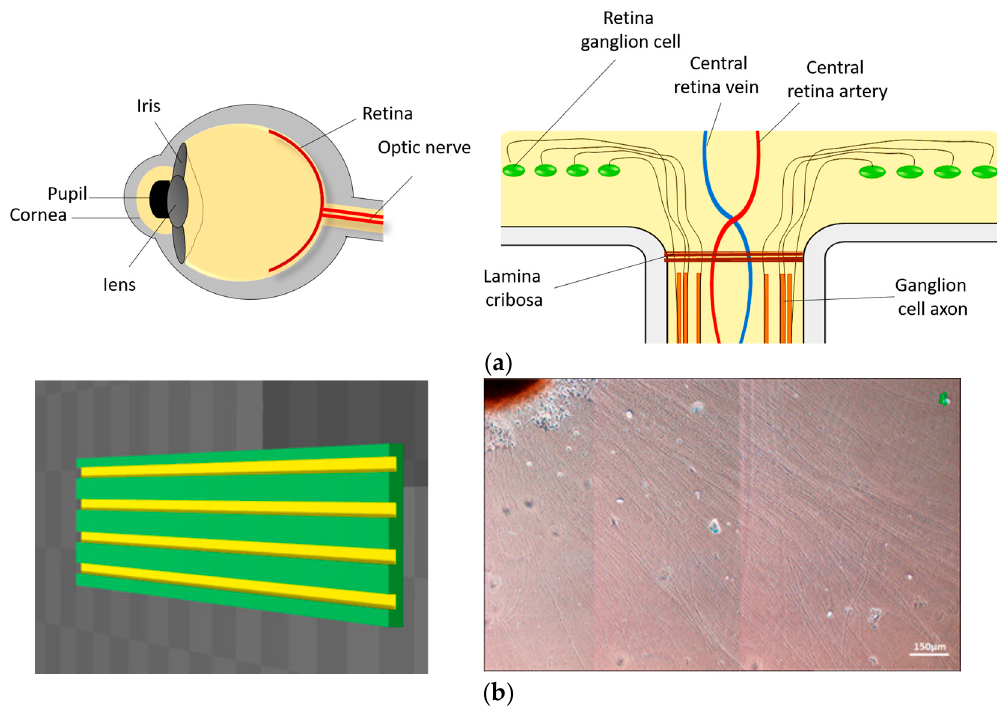
Figure 6. Summary. We used materials to construct an in vitro model that simulates the growth of the optic nerve. The axons of the optic nerve will grow and extend to the optic disc, where they are gathered and then connected to the cerebral cortex visual area ( a ). Use EVA as the material for the construction of the groove structure. The use of EVA as a material for the establishment of the trough structure can lead to axonal growth with a regular arrangement ( b ).